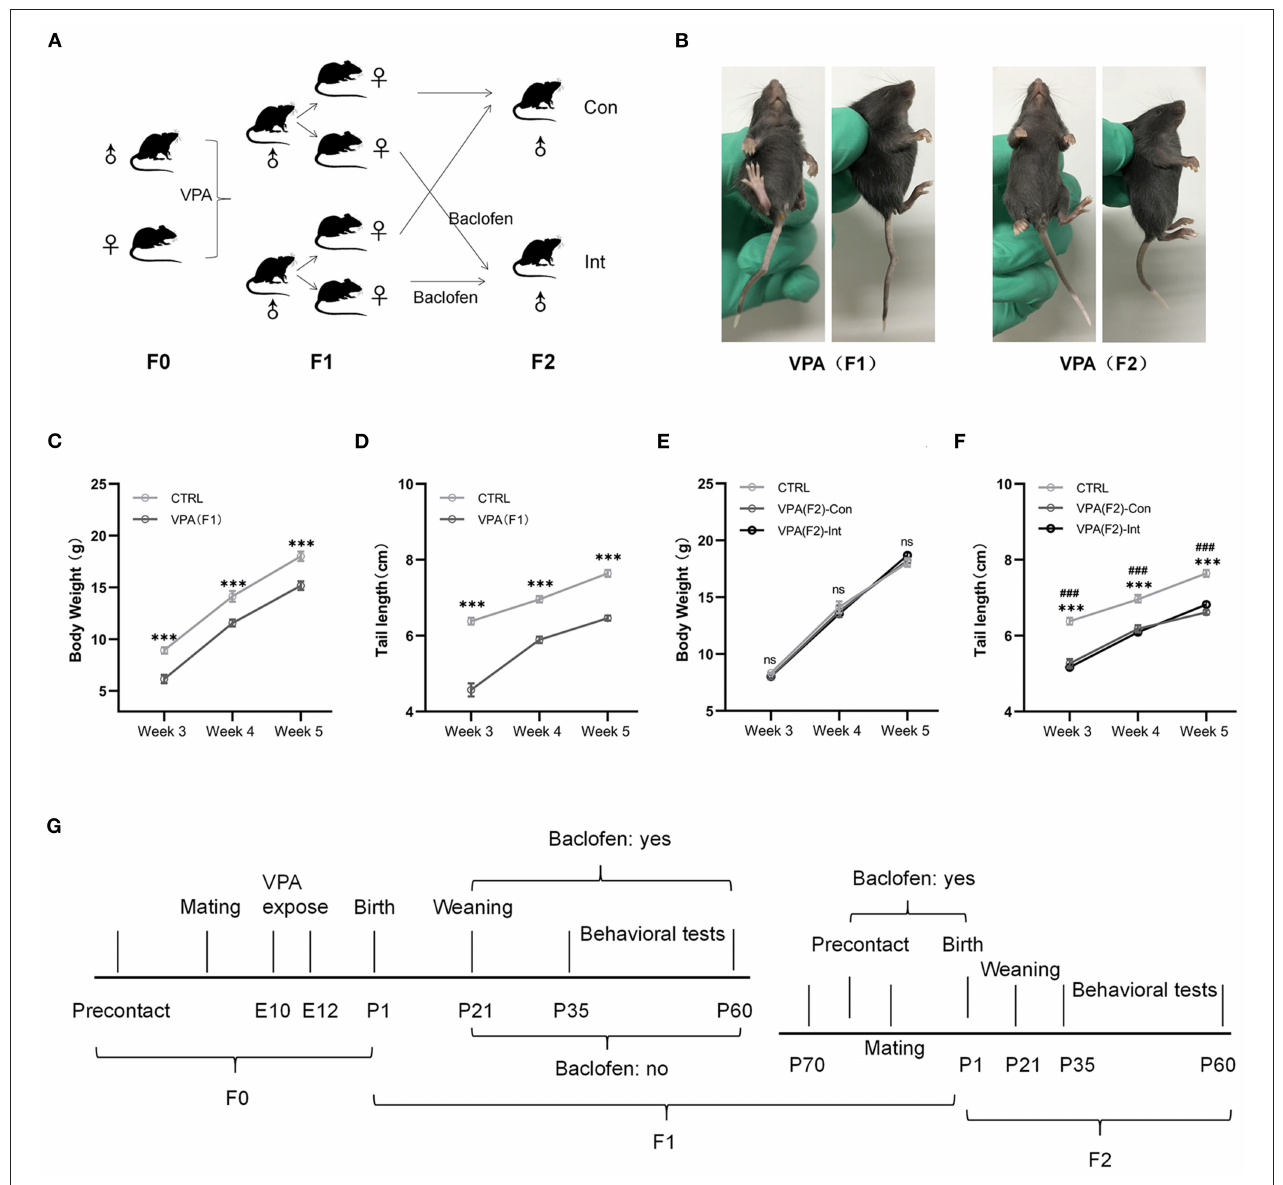
FIGURE 1 | F1 mice exhibited delayed growth and tail malformations, and F2 mice exhibited delayed tail growth without malformation. (A) The schematic diagram of F1 and F2 mice breeding. (B) The pictures of F1 mice show a tail deformity, and F2 mice did not show any tail deformity. (C,D) The body weight and tail length of male F1 mice were lower than those of male control mice from postnatal week 3–week 5 [two-way analysis of variance (ANOVA) followed by Bonferroni post-hoc test, n (CTRL vs. F1) = 14:14, *** p < 0.001]. (E,F) Compared to CTRL group mice, male F2-Con (without prenatal baclofen intervention) and male F2-Int (with prenatal baclofen intervention) mice did not show a significant difference in body weight, but the tail length of F2-Con and F2-Int mice was lower than that of male CTRL group mice in postnatal week 3–week 5 [two-way analysis of variance (ANOVA) followed by Bonferroni post-hoc test, n (CTRL vs. F2-Con vs. F2-Int) = 14:12:13, *** p < 0.001]. All data for all figures are plotted as the mean ± SEM. (G) A representative timeline of the experimental process. E: embryonic day; P: postnatal day; F0: CTRL mice; F1: first-generation mice (VPA-exposed mice); F2: second-generation mice (offspring of VPA-exposed mice); F1-Con: F1 mice with no oral baclofen treatment; F1-Int: F1 mice with oral baclofen treatment; F2-Con: F2 mice with no prenatal baclofen treatment; F2-Int: F2 mice with prenatal baclofen treatment; # indicates a comparison between the CTRL group and F2-Con groups; * indicates a comparison between the control (CTRL) group and F2-Int groups. Inspired by a previous report (30), we repeated the open-field test at 24-h intervals and measured the same indexes (task 2). The open-field exploration index (OFEI) was calculated as the distance traveled in the inner zone/the total distance traveled. The tasks started at ∼ 9:30